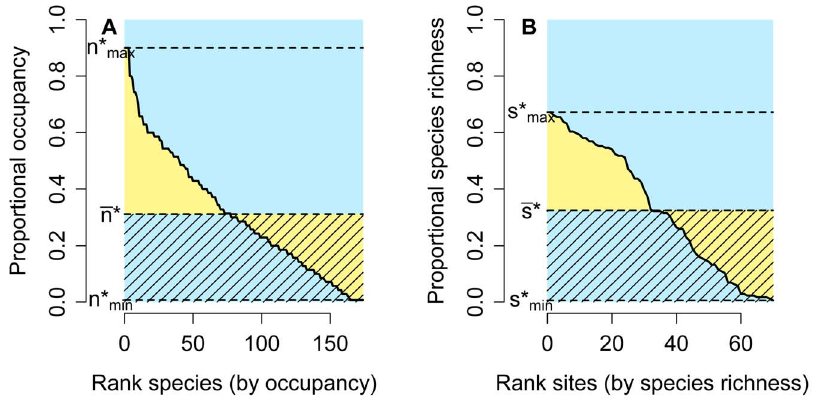
Figure 1. Rank distribution and rank diversity plots. Hypothetical example showing species ranked by their occupancy or range size (A), and sites ranked by their species richness (B). The area of the blue rectangle equals the number of species (in A) or the total number of sites (in B). Yellow areas measure the unevenness of the range-size (A) or species-richness frequency distributions (B), and the shaded areas are equal to the average species richness of sites (in the plot by species, A) or the average range size of species (in the plot by sites,